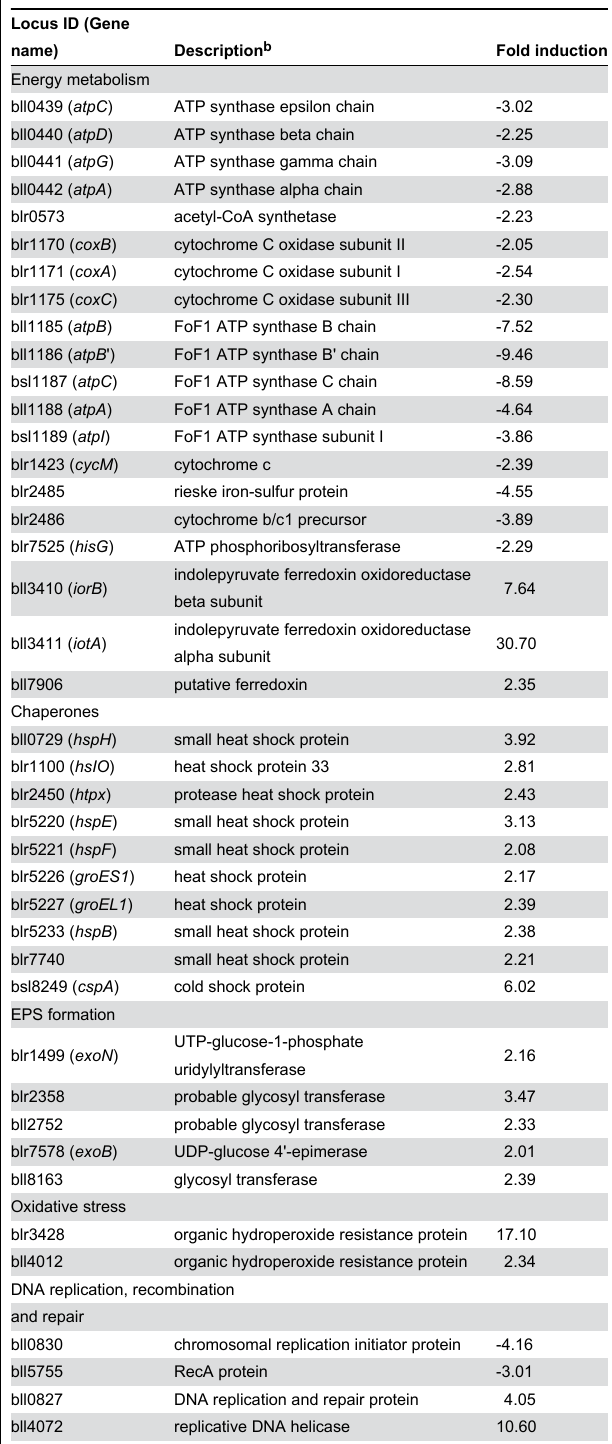
Table 1. A subset of the B. japonicum genes which were differentially expressed in response to a 1 mM IAA treatment for 3 h a